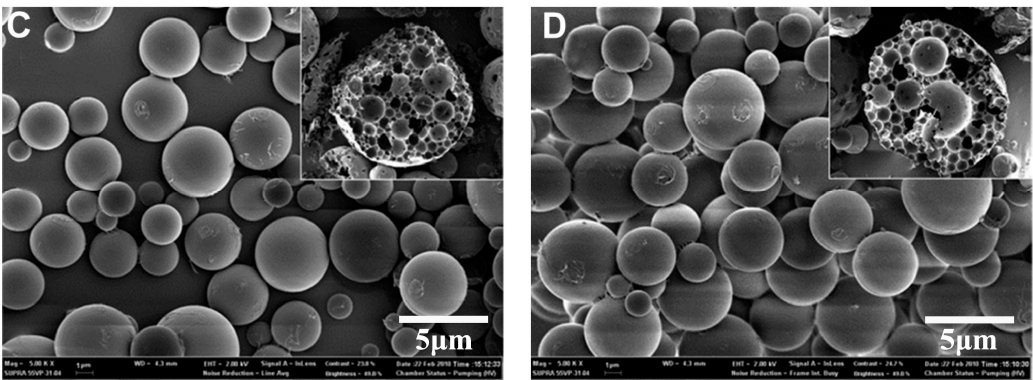
Figure 13. FE-SEM image of the surface and internal morphologies of the PLGA MPs ( A ); WSC-PLGA MPs ( B ), BmpB-PLGA MPs ( C ) and BmpB-WSC-PLGA MPs ( D ) [53].